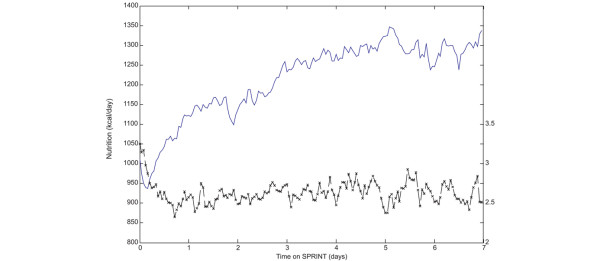
Average nutrition and insulin administration rates for the first 7 days on Specialised Relative Insulin Nutrition Tables (SPRINT). Nutrition rates are represented by solid lines, and insulin rates are represented by dashed lines with crosses.